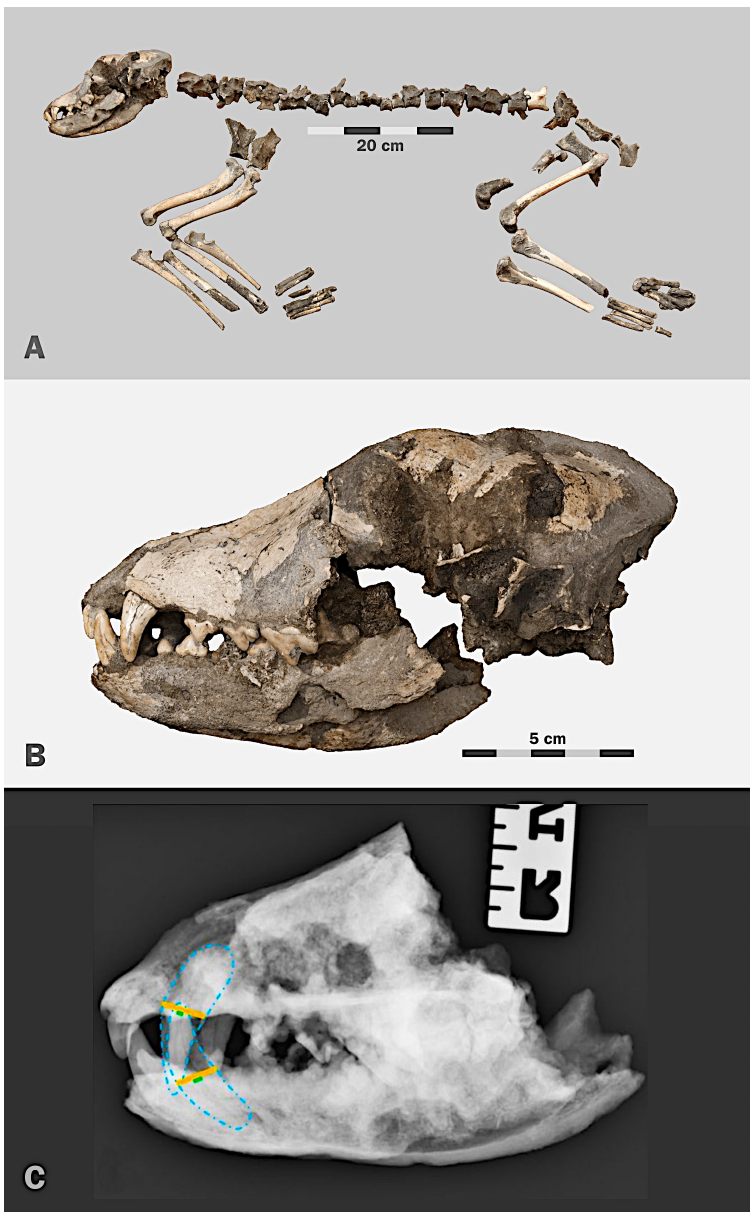
Figure 2. ( A ) Almost complete skeleton of the Muge dog (photograph kindly shared by JPRuas) (Detry and Cardoso, 2010) [3]; ( B ) skull showing deformations, fractures and calcareum concretions (photograph kindly shared by JPRuas) (Detry and Cardoso, 2010) [3]; ( C ) radiographic image of the Muge dog skull indicating the pulp canal (in blue) versus tooth widths (yellow) for both maxillary and mandibular canine teeth (surrounded by a blue dotted line), parameters that are useful for the estimation of age at